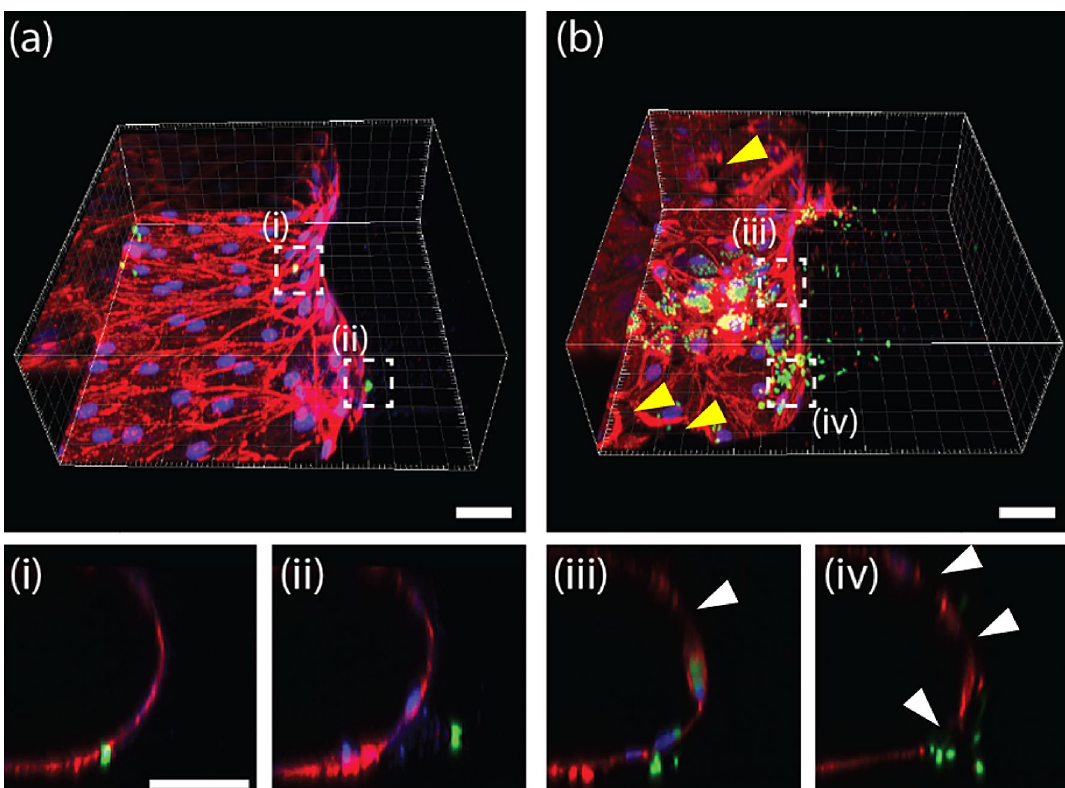
Figure 3. Tachyzoites (GFP (green)) transmigrating the EC monolayer (rhodamine-phalloidin (red) and DAPI (blue)) at ( a ) 12 h and ( b ) 60 h after infection. The image in (i–iv) at the bottom indicate a cross sectional view of the white box in ( a,b ). Tachyzoites were (i) either trapped in the EC monolayer or they (ii) migrated into the ECM after transmigration. Another image showing the coincident (iii) transmigration and proliferation (in an EC) of tachyzoites. (iv) Following egression, tachyzoites invade the ECM after disrupting the EC monolayer. Scale bar indicates 50 μm.